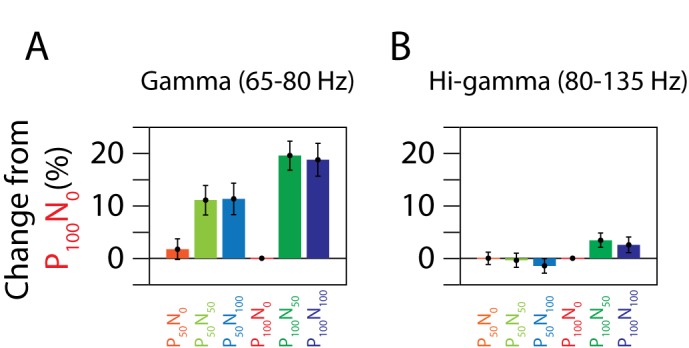
Percent changes in power from the P100N0 condition for the gamma (A) and hi-gamma (B) ranges.